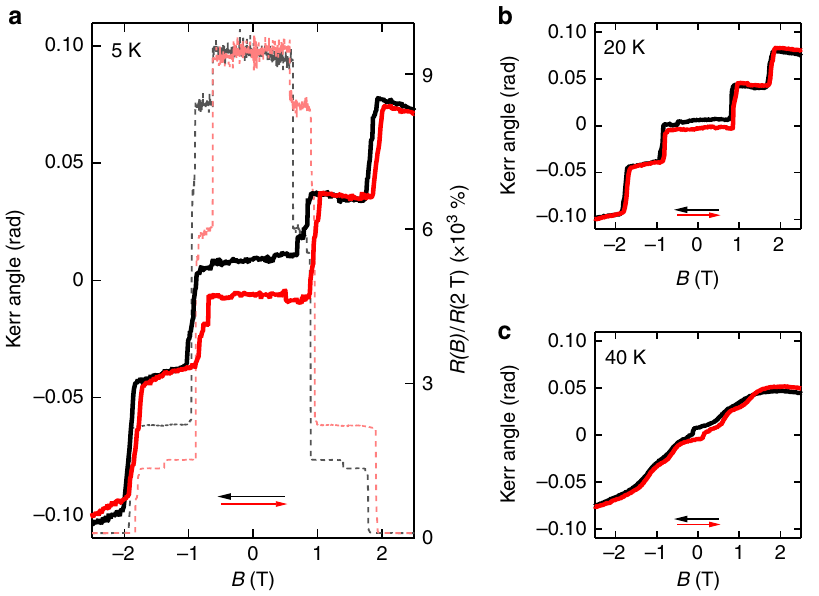
Fig. 5 Magneto-optical Kerr effect in few-layer CrI 3 . a Comparison between the Kerr angle (solid lines, left axis) and the magnetoresistance (dashed lines; data plotted as resistance ratio R ( B )/ R (2T), right axis) measured on a same device at 5 K. Kerr angle is measured in Faraday geometry with magnetic fi eld applied perpendicular to the plane of CrI 3 . Black and red curves correspond to sweeping the magnetic fi eld in the direction pointed by the arrows of the corresponding color. The Kerr angle exhibits jumps at magnetic fi eld values that coincide perfectly with the jumps observed in the magnetoresistance. b , c Kerr angle measured at 20 K and 40 K, respectively, as a function of magnetic fi eld. The evolution with temperature is virtually identical to that observed for the magnetoresistance (Fig. 3), with features shifting to lower fi elds and becoming broader as temperature is